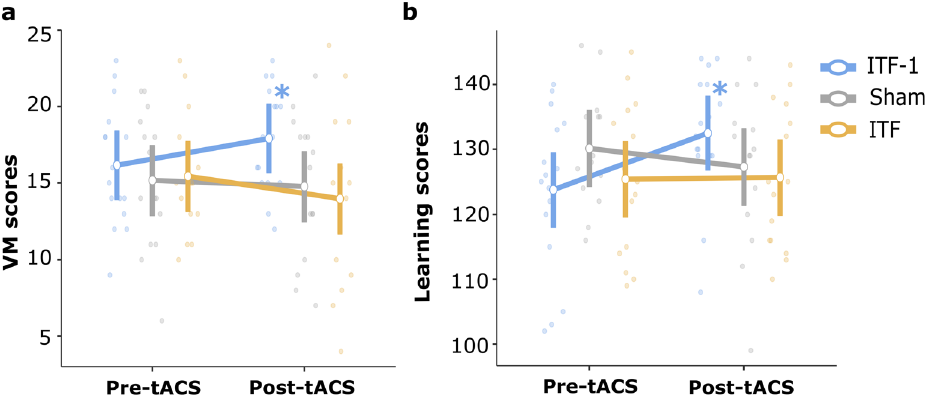
Figure 1. The significant behavioral results. ( a ) The mean values of the VM scores at pre- and post-tACS across the groups. The time*group interaction was significant (p = 0.016). The ITF-1 group had an increased VM score after the tACS. ( b ) The mean values of the Learning scores at pre- and post-tACS across the groups. The time*group interaction was significant (p = 0.011). ITF-1 group had an increased learning score after the tACS. See Supplementary Fig. 1 for additional representation. VM, visual memory; tACS, transcranial alternating current stimulation; ITF, individual theta frequency. The vertical bars denote 0.95 confidence intervals. Dots represent the observed scores. Asterisks indicate line reflects a significant change over